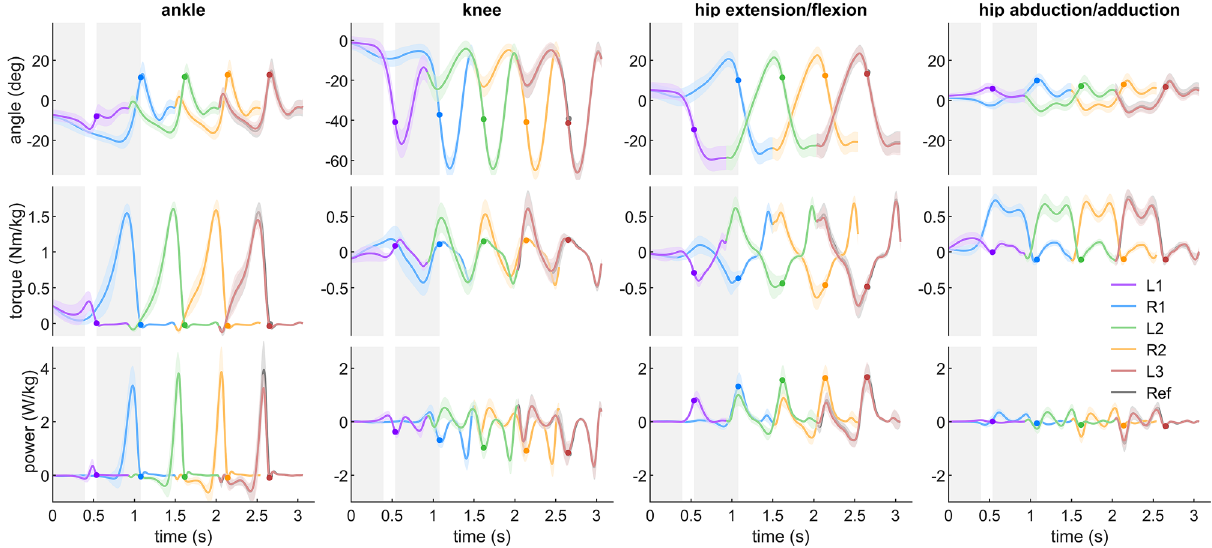
Figure 3. Ankle extension/flexion, knee extension/flexion, hip extension/flexion and hip abduction/adduction angle, torque and power during normal velocity gait initiation. Hip and knee extension, ankle plantarflexion, hip abduction, and extension torque are defined as positive. Solid lines denote the mean value over 23 subjects. The error bands denote ± 1 standard deviation. Time 0 is defined as the beginning of the gait initiation. Different colors denote different strides. L1, L2, L3 denote the first, second, and third stride on the left side, respectively. R1 and R2 denote the first and second stride on the right side, respectively. Ref denotes the regular overground walking at the self-selected preferred velocity. The dots denote the take-off timing.